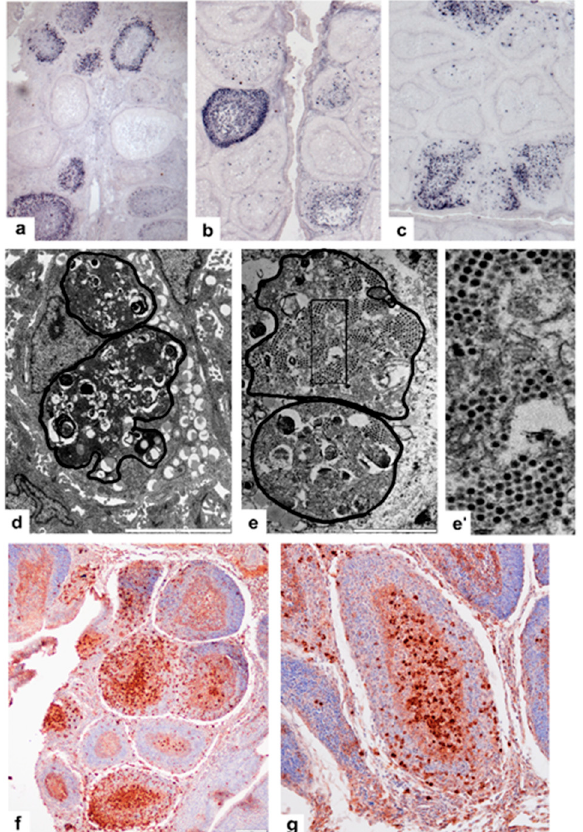
Figure 3. Immunocytochemistry of anti-IBDV; 5A10 mAb, 2 days pi. ( a ) In the very virulent virus infected birds, the majority of 5A10 positive cells are located close to the CMEA(s) and they are able to assemble in the periphery of the cortex. Many individual cells are between the CMEA(s) and periphery of the cortex. Follicles are still found without infected cells. ( b ) The Delaware-E strain shows much fewer infected follicles, but occasionally a heavily infected follicle occurs, which differs from that of very virulent virus infected follicles. Many IBDV-positive cells are in the medulla and the cortex is homogenously covered by IBDV-positive cells. ( c ) The vaccine 228E virus positive cells, seem to be similar to that of the Delaware-E strain. ( d ) Macrophage-like cells (Mal) from a vaccine-strain virus inoculated chicken. The cell has two corpuscles (fused BSDC granules, outlined) and the periphery of the cytoplasm is full of neutral lipid droplets. ( e ) Higher magnification from a Mal. The corpuscles (outlined) are full of virus particles and the dark nodules and myelin—the rest is corpuscles material. ( e (cid:48) ) is an inset of ( e ). The rectangle shows higher magnification of the virus particles. ( f ) At 36 h pi, the caspase3 staining shows a highly variable number of apoptotic cells in the follicles. ( g ) Higher magnification shows that the caspase3-positive cells are found in the medulla and a few cells occur in the periphery of the